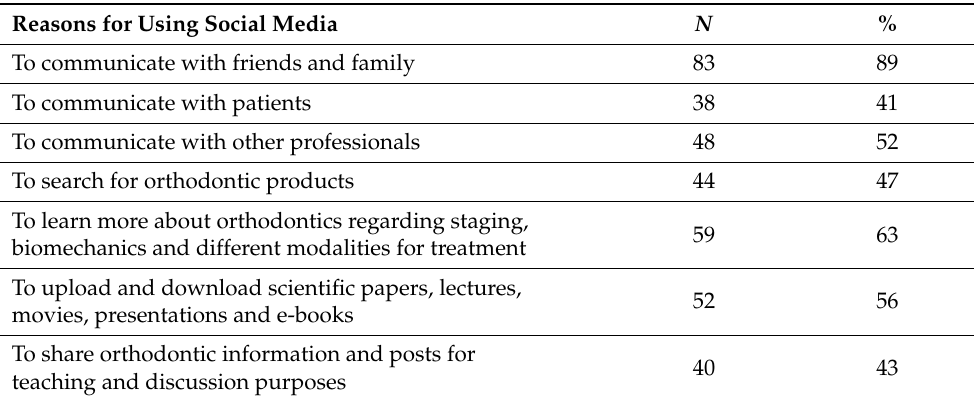
Table 2. Frequency distributions and percentages of the participant’s responses regarding the reasons for using social